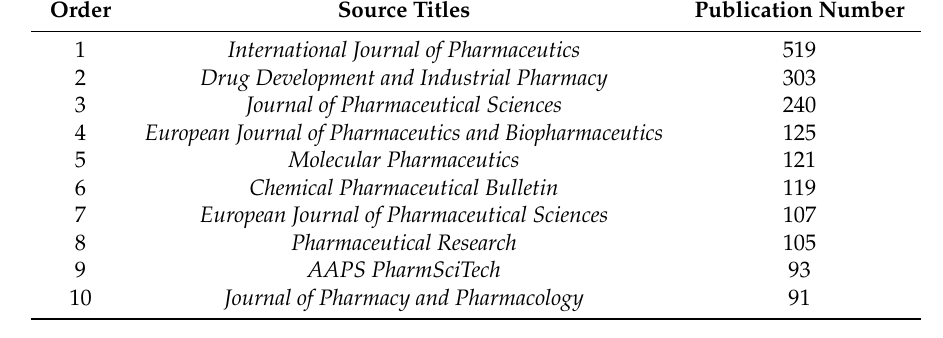
Table 4. Top 10 active journal and publication number about solid dispersions from 1980 to 2015.